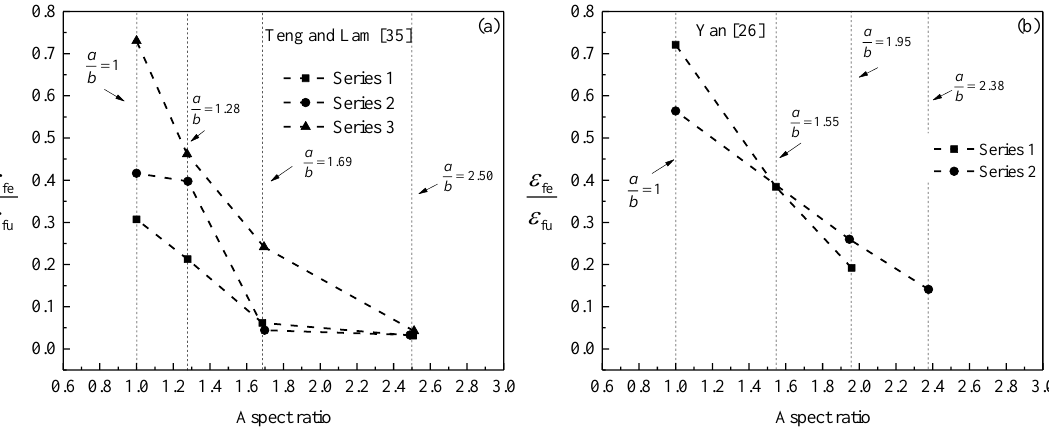
Figure 1. Effect of FRP confinement stiffness on hoop strain (( a ) specimens of Teng and Lam [35] and ( b ) specimens of Yan [26]): ε fe = average FRP hoop strain from gauges on minor and major section sides; ε fu = FRP tensile strain obtained from flat test coupons.